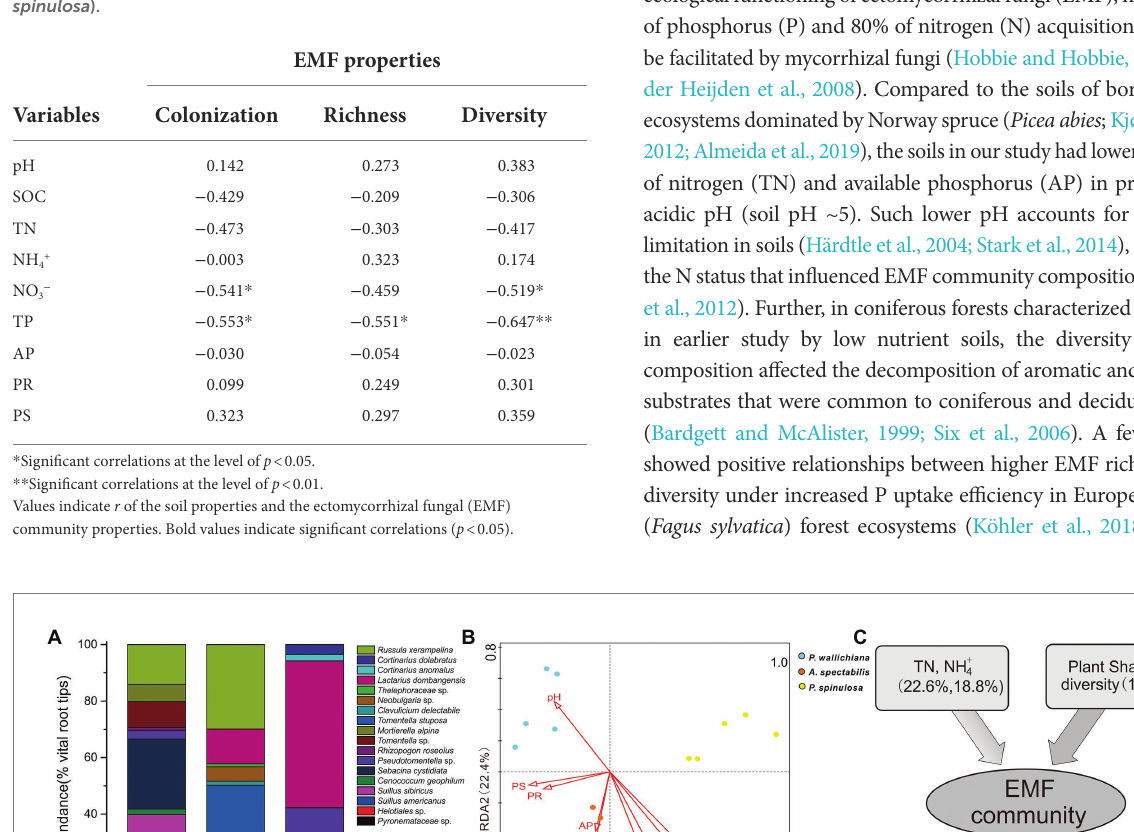
TABLE 2 The Pearson correlations considering the soil properties and the ectomycorrhizal fungal (EMF) community properties at all the three forest sites ( Pinus wallichiana , Abies spectabilis , and Picea spinulosa ).